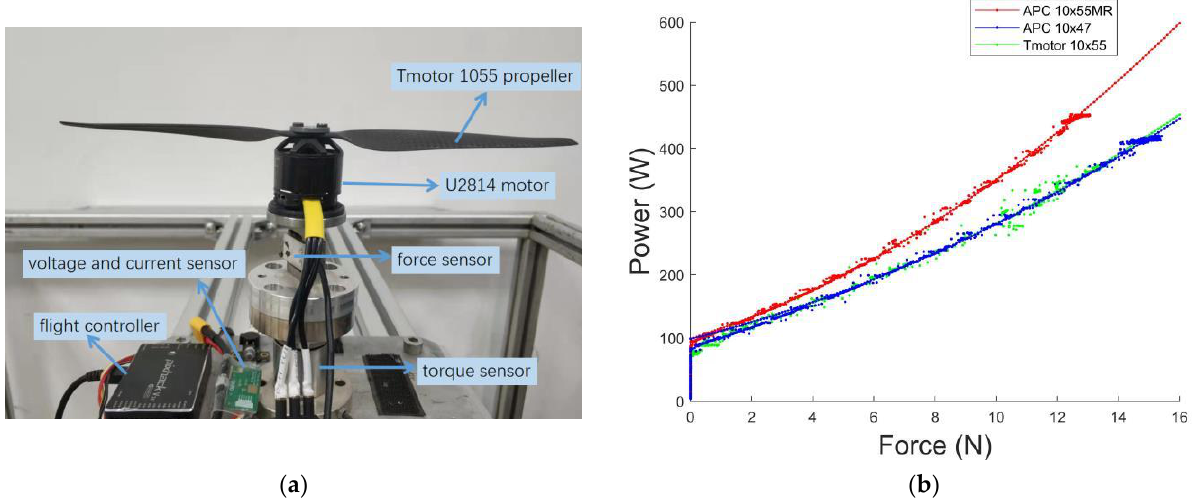
Figure 10. Propeller lift and actual power test: ( a ) lift/power test bench ( b ) fitting curve between lift and power consumption.